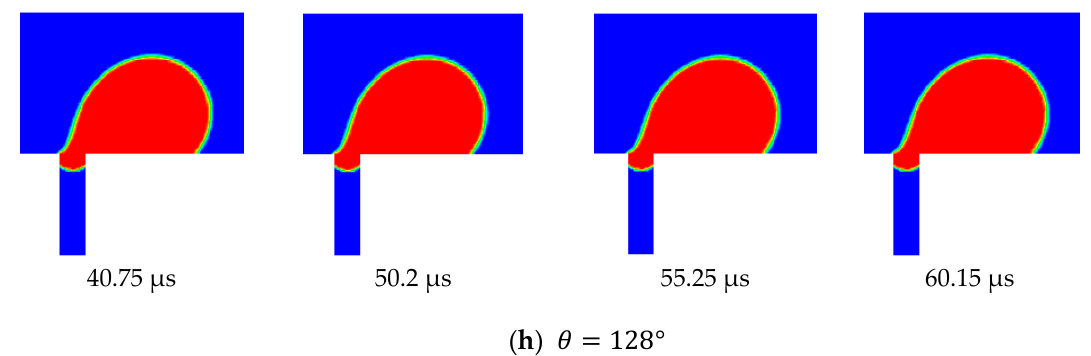
Figure 12. Side view snapshots of the droplet for different contact angles. It is clear that when the contact angle was large and no pinning occurred, the droplet passed along the pore opening and the interface at the pore opening recoiled toward the droplet. As the contact angle became smaller, two things happened, namely, the droplet spread over the surface more and the interface inside the pore moved downward. This continued until the droplet was no longer able to either recoil at the interface inside the pore or it was broken. In the considered example, the following parameters were set to be constant: TMP = 0.9 bar, v top wall = 0.5 m/s, σ = 0.025 N/m, θ varied between 135 ◦ and 128 ◦